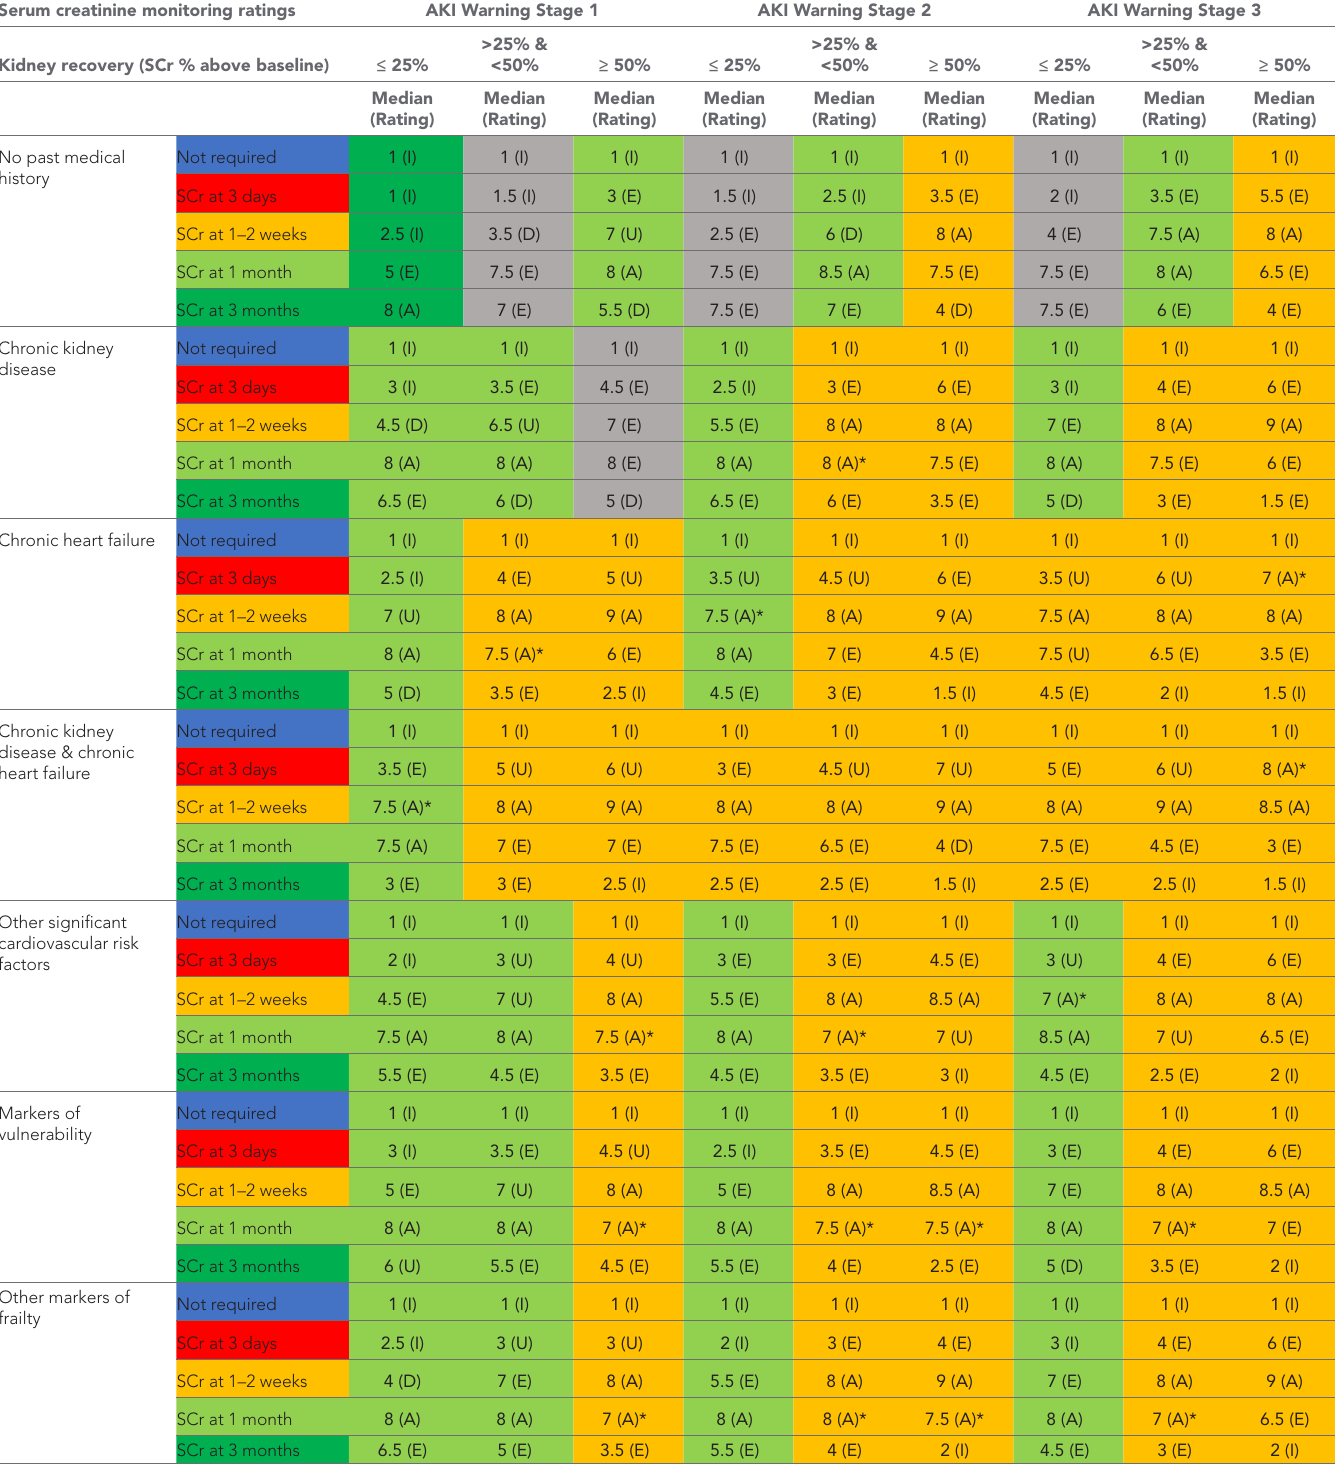
Table 4 Summary of timeliness for performing the first post- discharge serum creatinine test. Serum creatinine monitoring ratings AKI Warning Stage